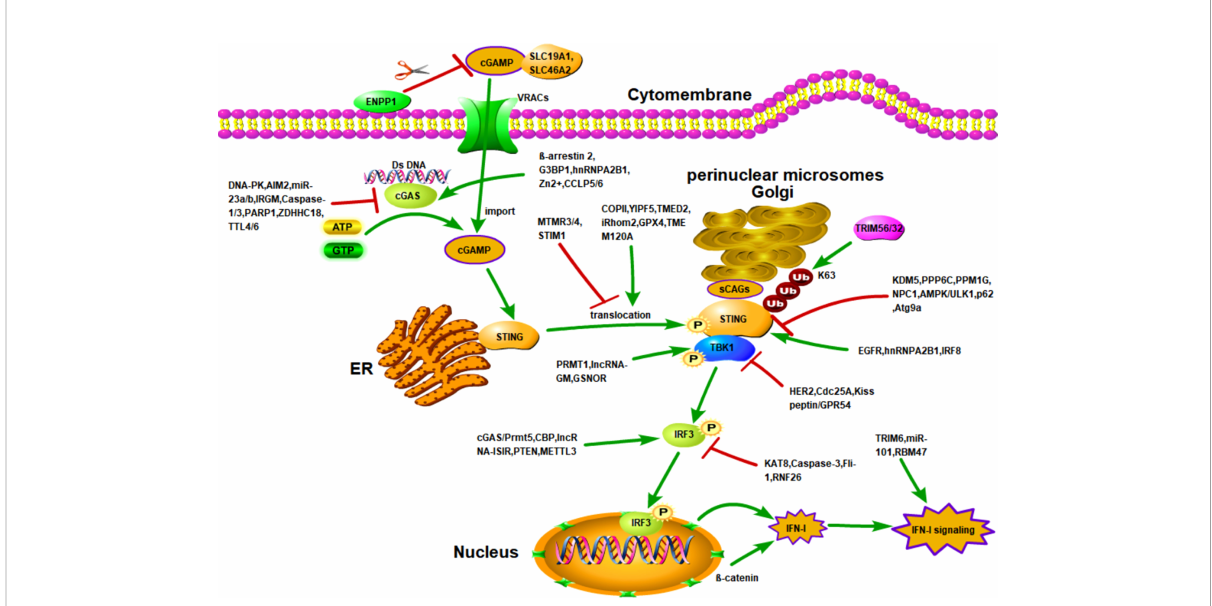
FIGURE 1 Activation of cGAS/STING signaling and regulation of cGAS/STING signaling by other molecules. Activation of STING is dependent on the presence of intracellular cGAMP. There are two sources of intracellular cGAMP. First, upon binding to DNA, cGAS is activated to catalyze the synthesis of intracellular cGAMP. Second, extracellular cGAMP is transported into the cell through importers. After cGAMP binds to STING, STING is translocated to the Golgi apparatus to bind sCAGs and is linked to the K63-linked ubiquitination by TRIM32 and TIRM56, which induces STING to recruit TBK1 and activate IRF3-induced IFN-I production. The cGAS/STING cascade is controlled by various factors. For example, DNA-PK, AIM2, miR-23a/b, etc. reduce the activity and expression of cGAS through different mechanisms. However, G3BP1, b -arrestin 2, and hnRNPA2B1 enhance the activity and expression of cGAS through different mechanisms. In addition, the entry of extracellular cGAMP into cells is affected by the traf fi cking of importers SLC19A1 and SLC46A2, as well as by VRACs and ENPP1. Numerous molecules also regulate the translocation of STING. For example, COPII, YIPF5i, Rhom2, etc., enhance the transport of STING from the ER to the Golgi and perinuclear microsomes. However, MTMR3/4 and STIM1 inhibited the translocation of STING. In addition, the activation of STING are also positively and negatively regulated by various factors, such as KDM5, PPP6C, and